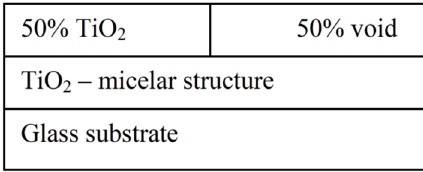
Figure 8. Used ellipsometric model which involves a layer with an additional void.